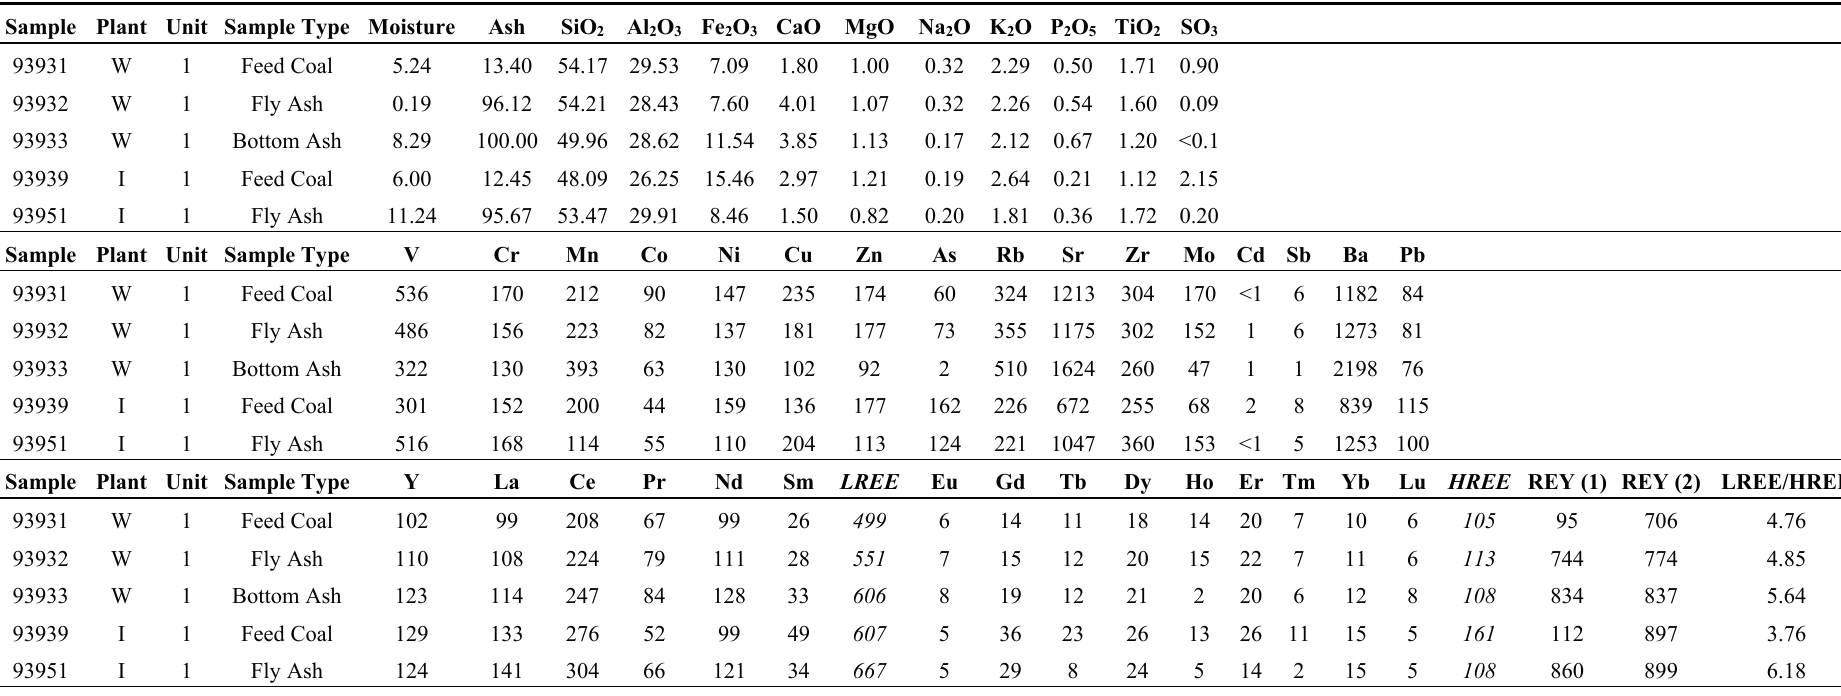
Table 5. Moisture (% as-received basis), ash (% dry basis), major oxides (% ash basis), minor elements (ppm, ash basis) and rare earth elements and yttrium (ppm, ash basis) for two power plants burning coal blends dominated by the Fire Clay coal. Sample Plant Unit Sample Type